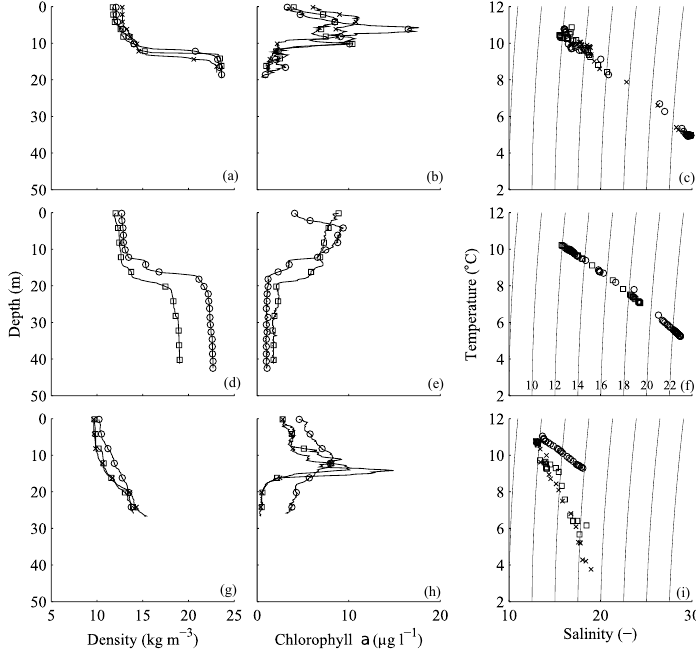
Figure 7. Vertical profiles of density (a, d, g) and chlorophyll a (b, e, h) , and the corresponding distributions of temperature and salinity (in Practical Salinity Units) (c, f, i) . In the salinity–temperature plots the lines are contours of constant density (minus 1000kgm − 3 ). The observations were made on 4 May 2004 between 07:35 and 08:30UTC at stations 14 (circles), 16 (squares), and 18 (crosses), all shown in (a) – (c) on 4 May at 08:51 at Station 51 (circles) and on 5 May at 05:17 at Station 20 (squares), shown in (d) – (f) , and on 5 May between 05:45 and 08:49 at stations 21 (circles), 27 (squares), and 29 (crosses), shown in (g) – (i)